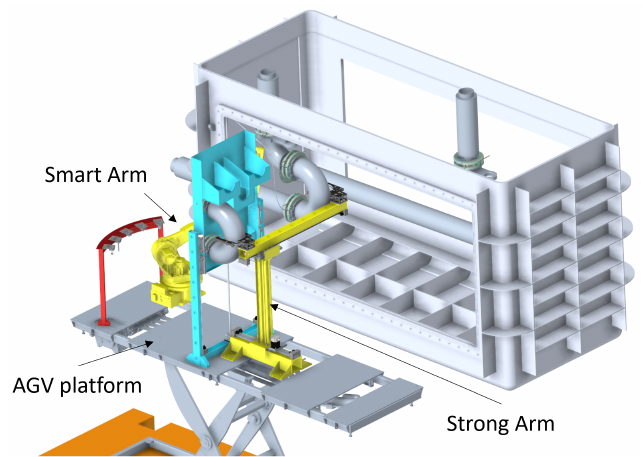
Figure 2. Remote-handling maintenance concept for the